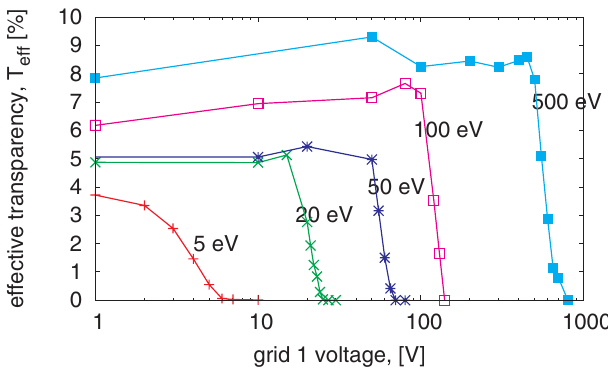
FIG. 15. (Color) Effective transparency of the electron detector. The flux coming from the electron gun vanishes when the grid voltage equals the energy of the incoming electron jet. The transparency for electrons with an energy of 500 eV is twice as large as the transparency for electrons with 5 eV.